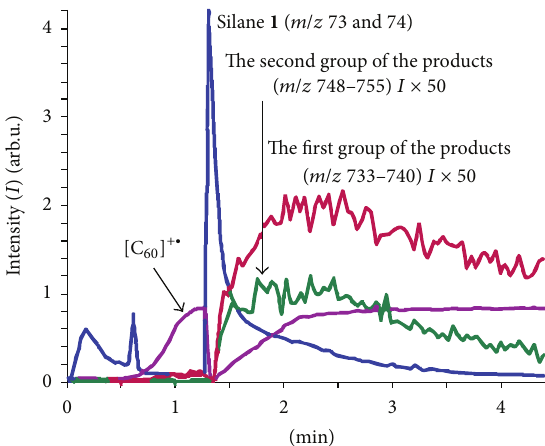
Figure 2: Mass chromatogram recorded in the course of an exper- iment with C 60 and tetramethylsilane ( 1 ) effected in the IC of a mass spectrometer by protocol A . The traces of the other products detected behaved